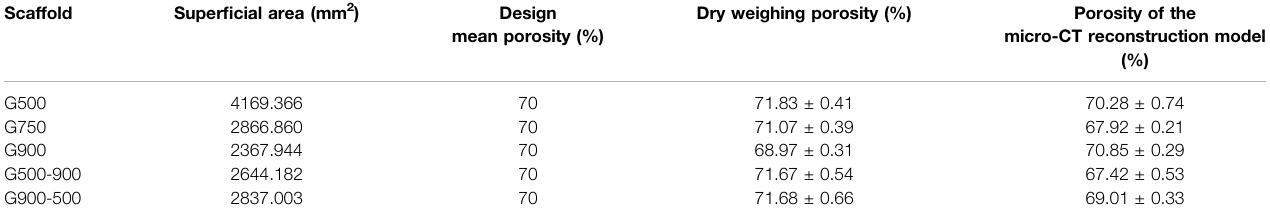
TABLE 1 | Modeling parameters and actual porosity of the scaffolds. Scaffold